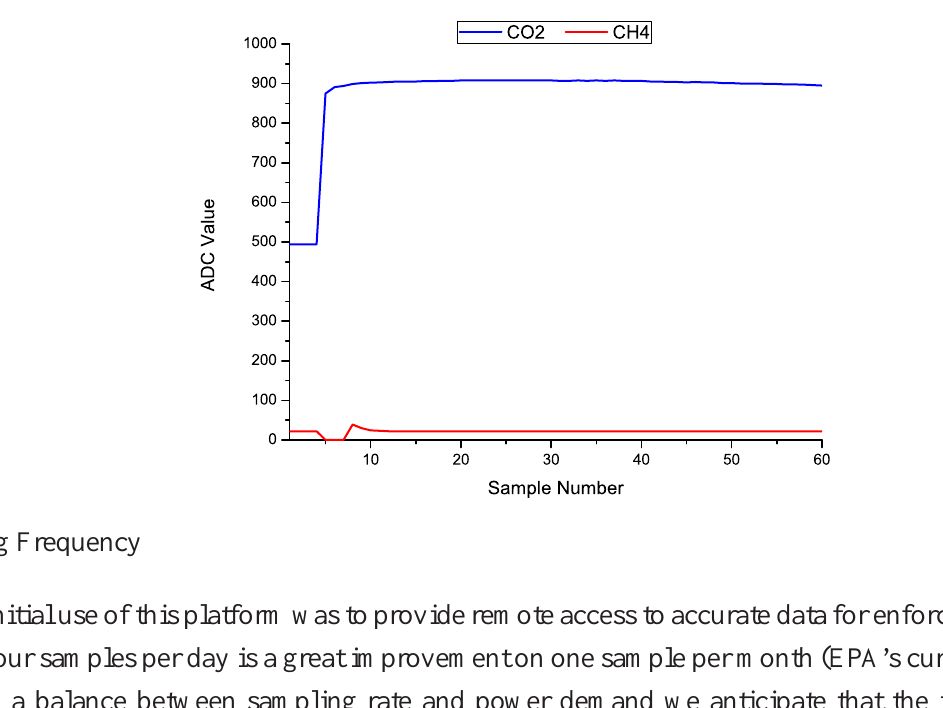
Figure 13. Profile of our “sample only” system, note the same signature as Figure 12, which possibly indicates that only the sample stage is needed to measure the air emissions at a given landfill